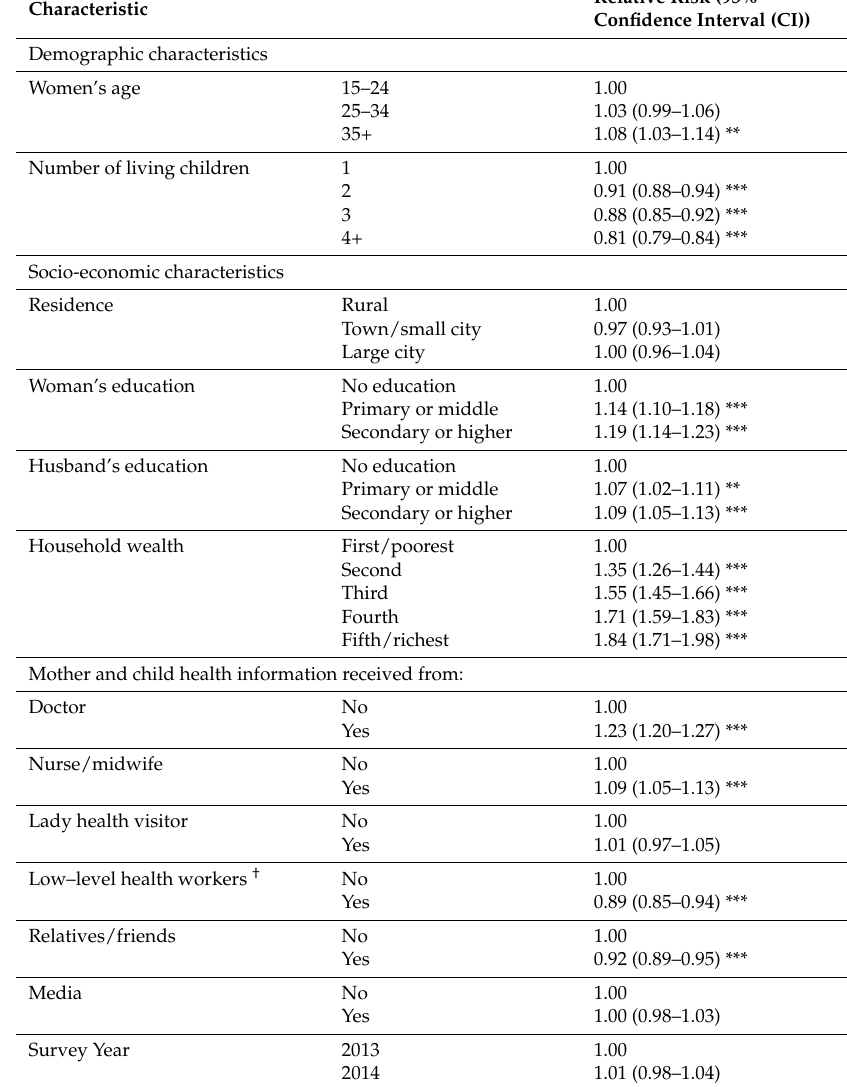
Table 2. Generalized linear model with log link and a Poisson distribution: medical facility birth by demographic and socio-economic characteristics and maternal and child health information